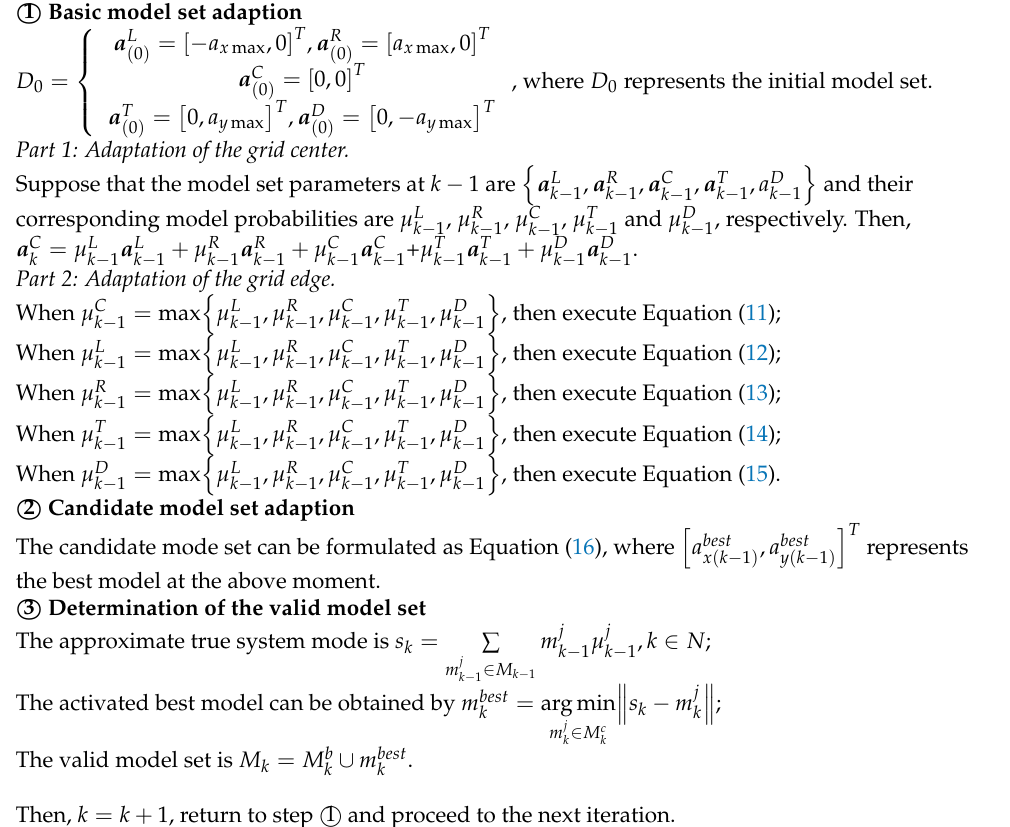
Algorithm 1: Pseudo codes for the proposed MSA